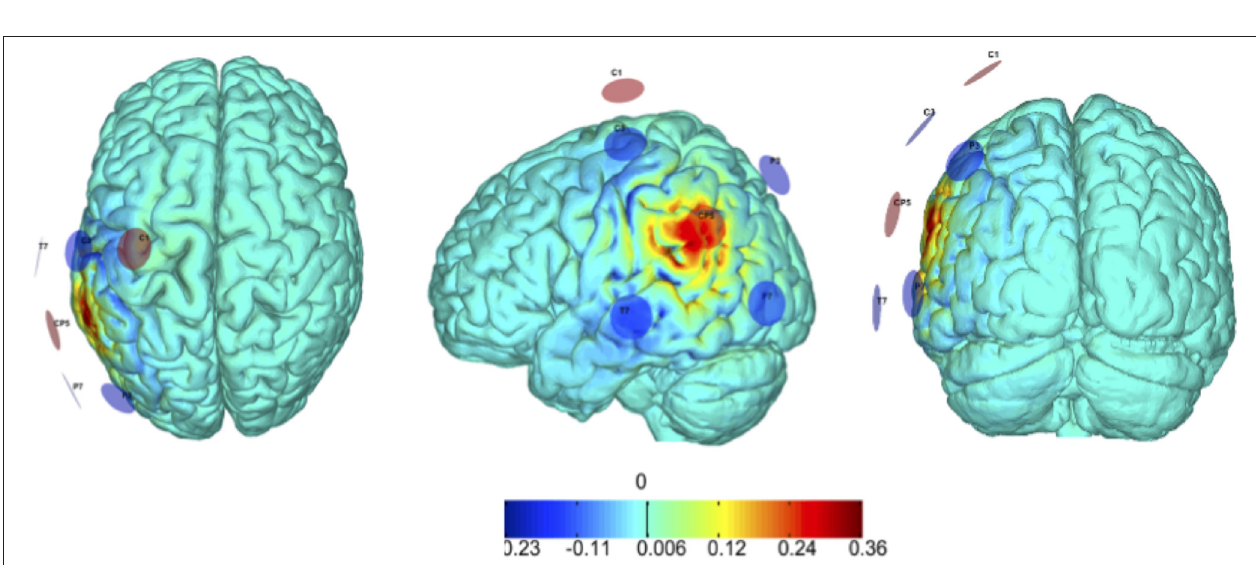
FIGURE 1 | Roadmap of EEG-guided personal tACS to improve autobiographical memory. (A) High-density EEG recording during a personalized autobiographical memory task that requests to decide whether pictures are self-related or not. (B) Analysis of the high-density EEG in terms of stimulus-evoked frequency modulations. Determination of the individual peak frequency of event-related synchronization and source localization of this frequency based on individual structural MRI head models. (C) tACS montage optimization based on the EEG result to perform multi-focal stimulation at the individual gamma peak frequency targeting the sites determined by the EEG source imaging.